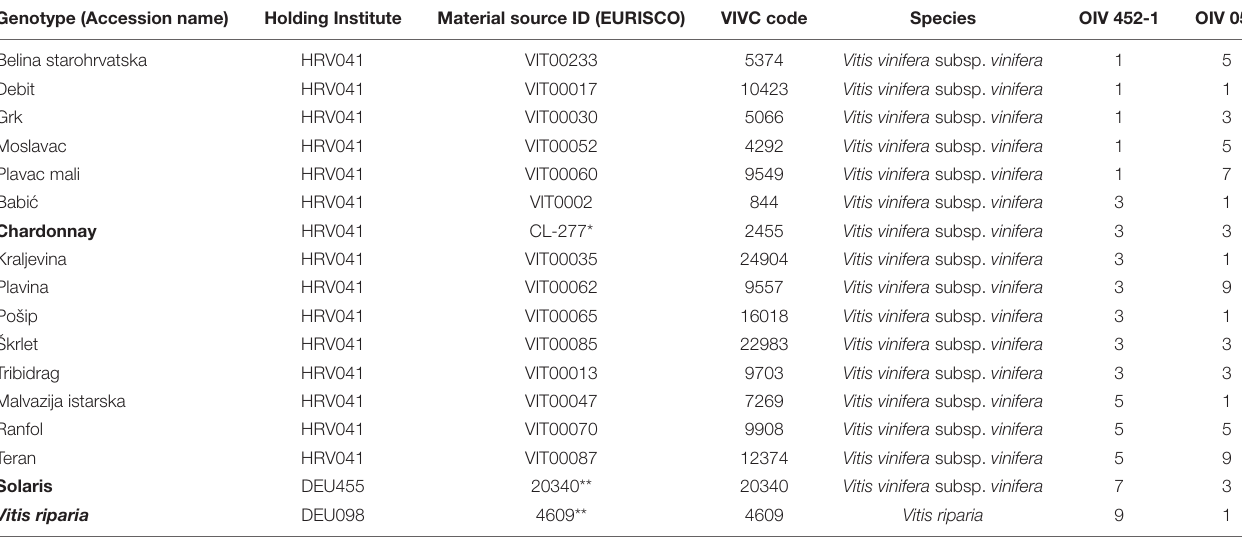
TABLE 1 | Genotypes, additional information on the plant material, the corresponding OIV classes of resistance of the genotypes to P. viticola (OIV 452-1), and the density levels of the trichomes on abaxial leaf sides (OIV 053) according to OIV (2009). Genotype (Accession